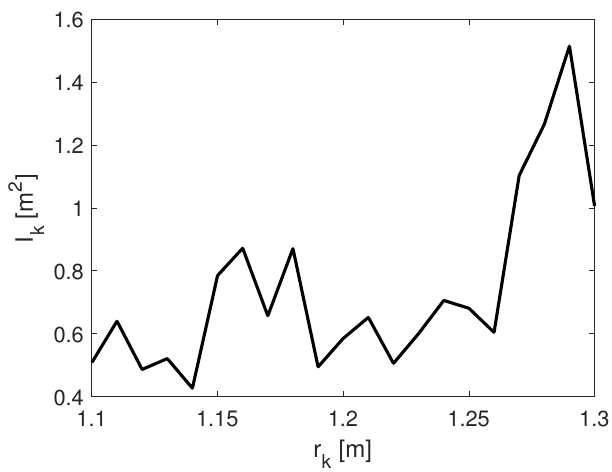
Figure 8. Plot of I k as function of r k .